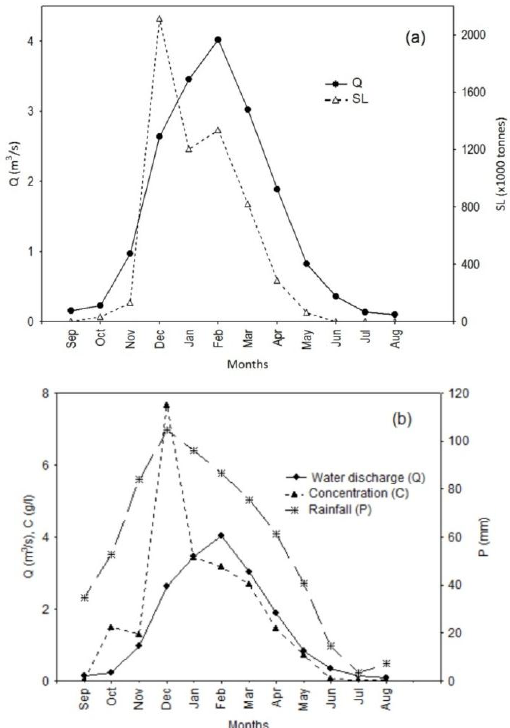
Figure 5: Variation of: (a) monthly suspended sediment loads and monthly mean discharges; (b) monthly mean suspended sediment concentrations, monthly mean discharges and monthly mean rainfalls.